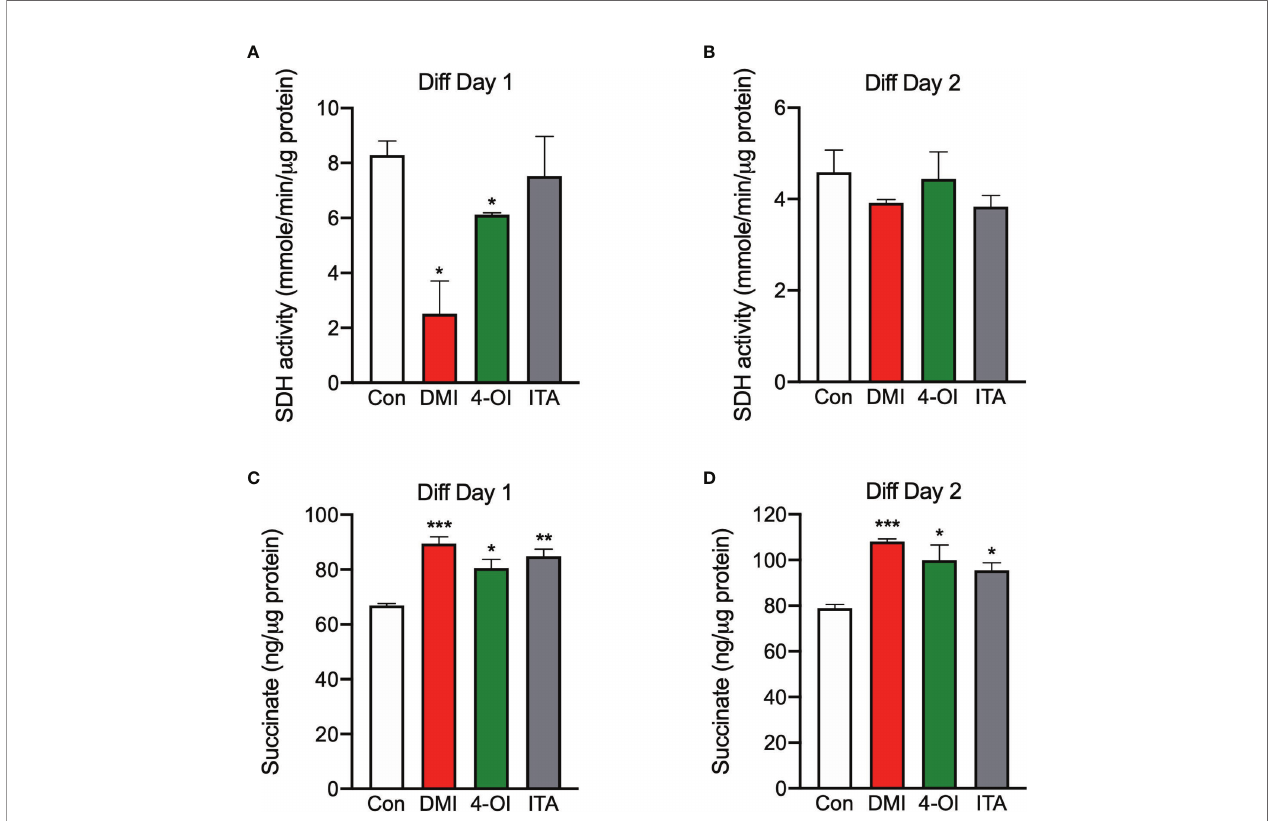
FIGURE 3 | Itaconate derivatives inhibit succinate dehydrogenase and accumulate intracellular succinate during C2C12 myogenesis. Succinate dehydrogenase (SDH) activities in the presence of itaconate derivatives at day 1 (A) and day 2 (B) of differentiation (n = 6). Succinate levels in the presence of itaconate derivatives at day 1 (C) and day 2 (D) of differentiation (n = 6). * denotes p< 0.05, ** p <0.01, *** p <0.001, **** p <0.0001 compared to control based on